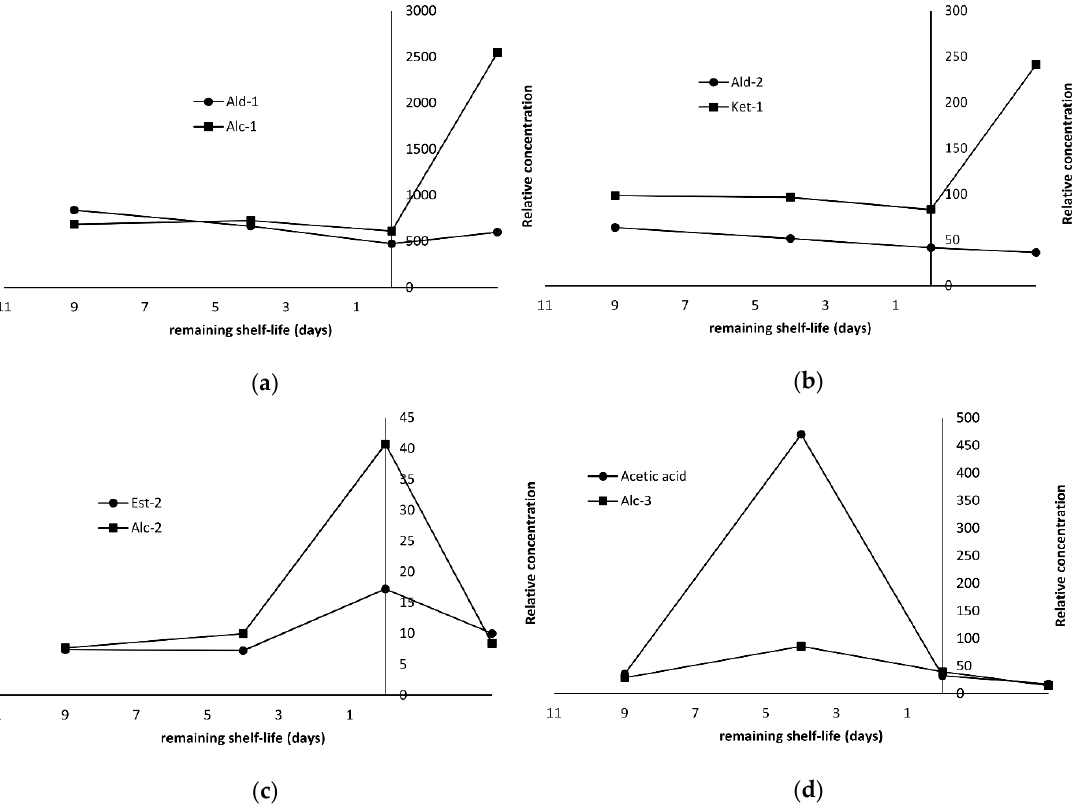
Figure 5. Changes of volatiles in relation to remaining shelf life during storage of salmon slices under MAP at 2 °C. ( a ) Group Ald-1 and Alc-1; ( b ) Group Ald-2 and Ket-1; ( c ) Group Est-2 and Alc-2; ( d ) Group Alc-3 and Acetic acid. The compounds included in each group are described in Table 1.